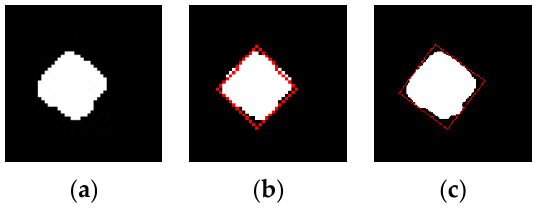
Figure 4. The contour of a square marking point before and after enlarging: ( a ) Segmented image of a marking point before enlarging, ( b ) Integrity contour of a marking point before enlarging, and ( c ) Integrity contour of a marking point after enlarging.